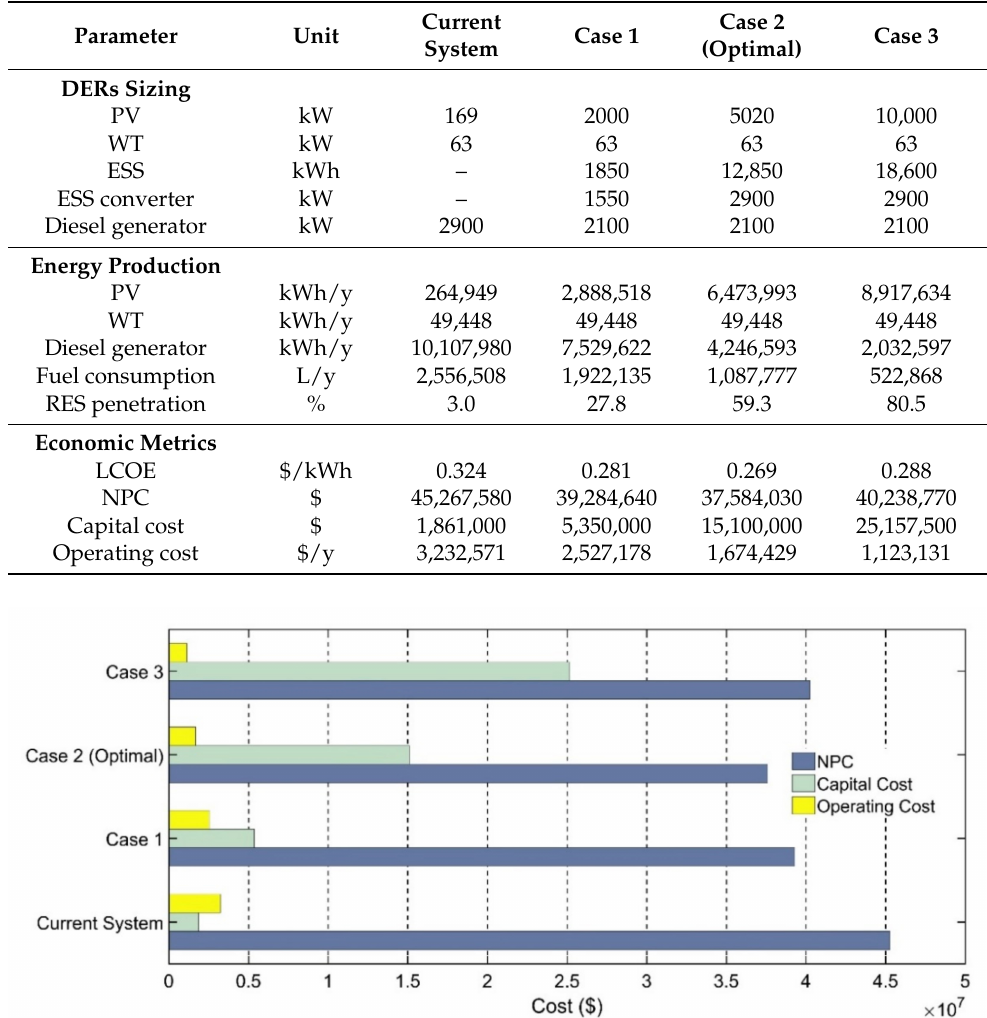
Figure 17. Cost comparison of selected cases for Deokjeok Island